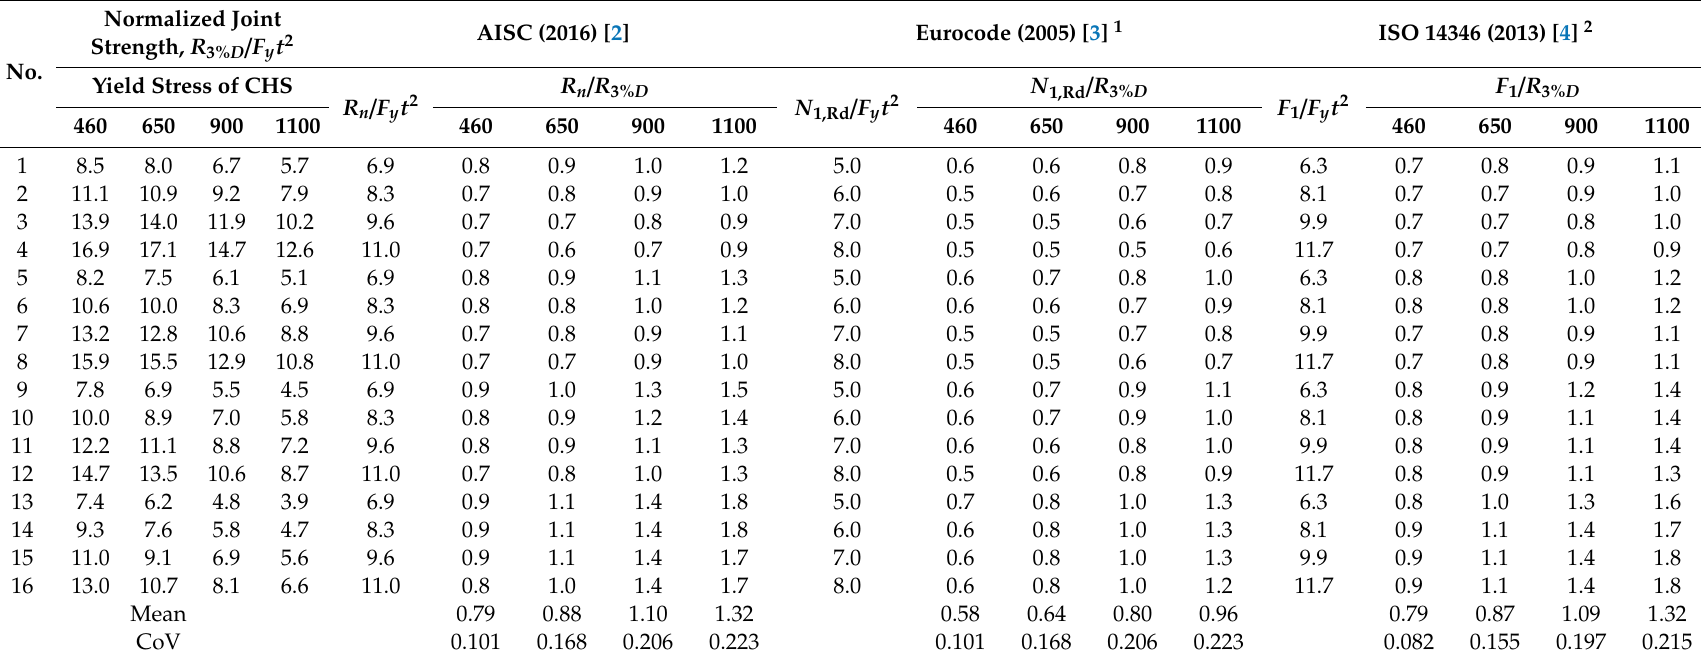
Table 12. Comparison of design equations with the joint strength using the ultimate deformation